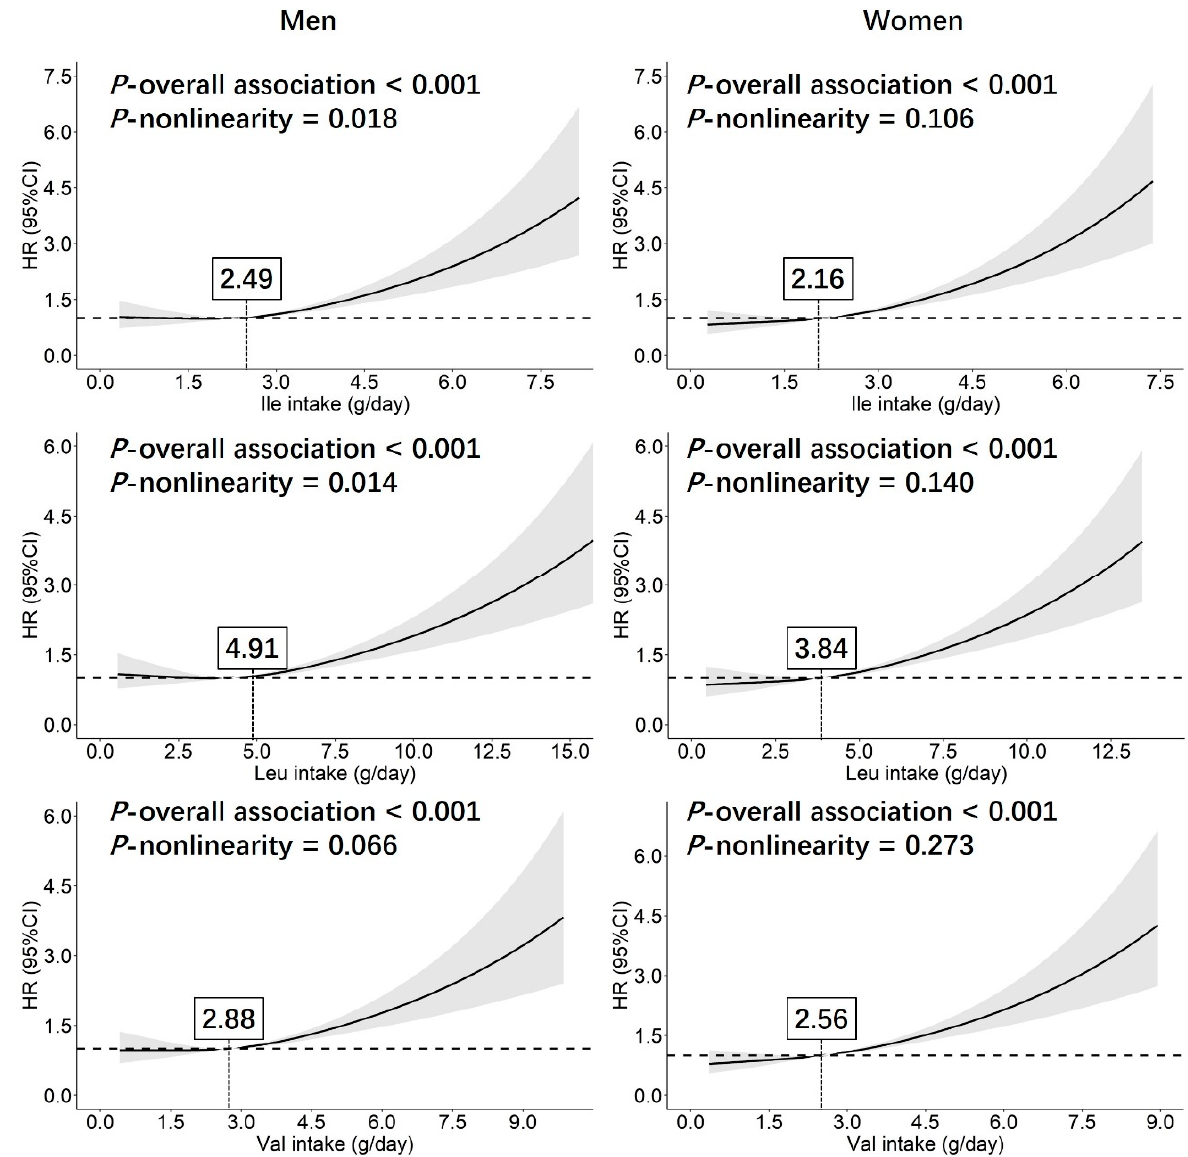
Figure 1. Nonlinear relationship between dietary BCAAs’ intake and hypertension risk. The estimate of nonlinearity was adjusted for age, ethnicity, education, urban residents, diagnosed T2DM, physical activity, smoking, alcohol drinking, intakes of energy, carbohydrate, fat, protein, and salt intake. Abbreviations: BCAA: branched-chain amino acid; Ile: isoleucine; Leu: leucine; Val: valine; HR: hazard ratio; 95% CI: 95% confidence Table 4. Adjusted associations between hypertension incidence and continuous variables of BCAAs in subgroups divided using quartiles ( n = 8491).